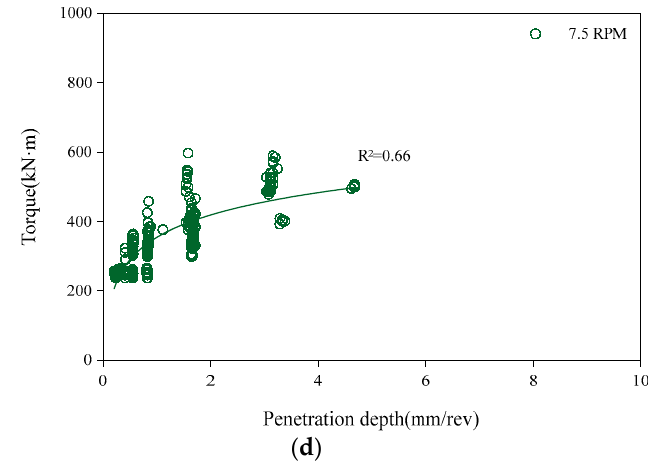
Figure 7. Relationships between penetration depth and torque, ( a ) At 1.5 RPM; ( b ) At 4.5 RPM; ( c ) At 6.0 RPM; ( d ) At 7.5 RPM.